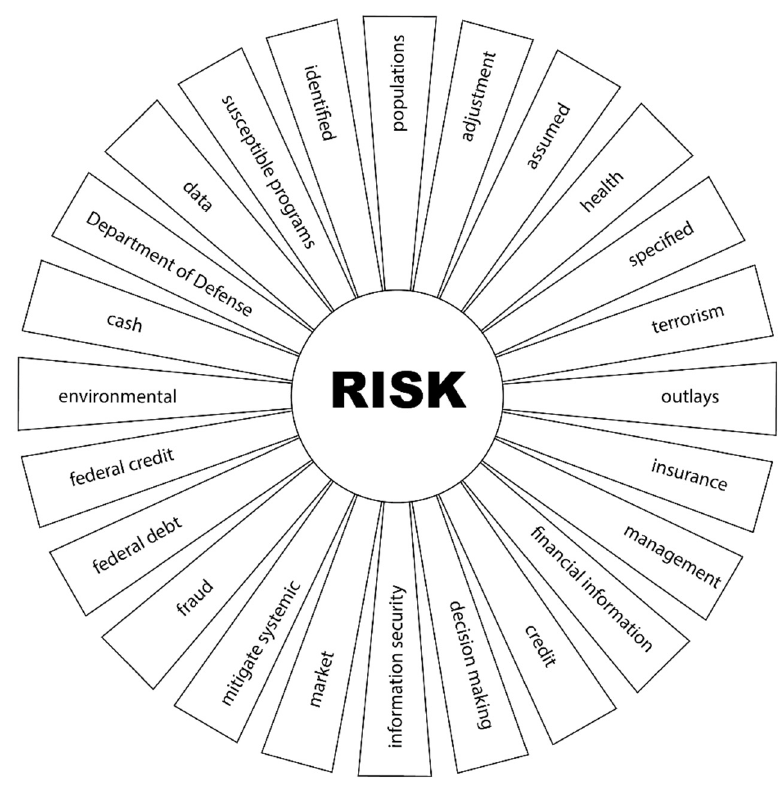
Figure 5. The network of the form “risk” of U.S. Federal Government.